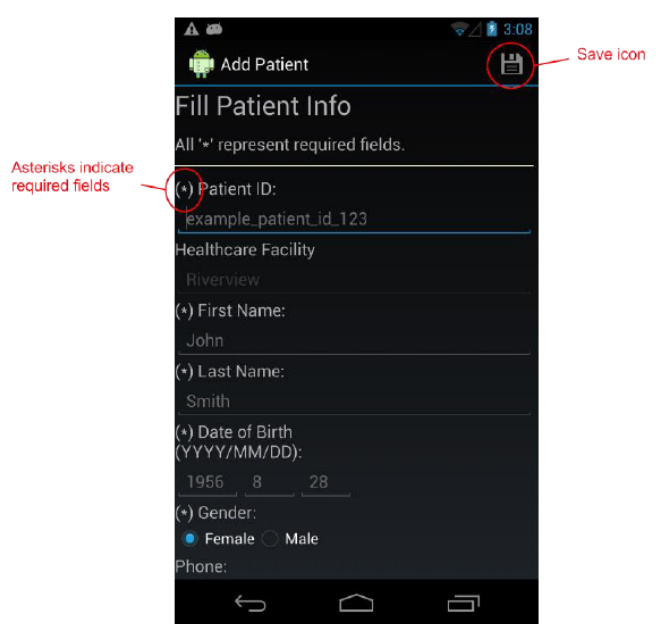
Figure 1. The Add Patient Screen.